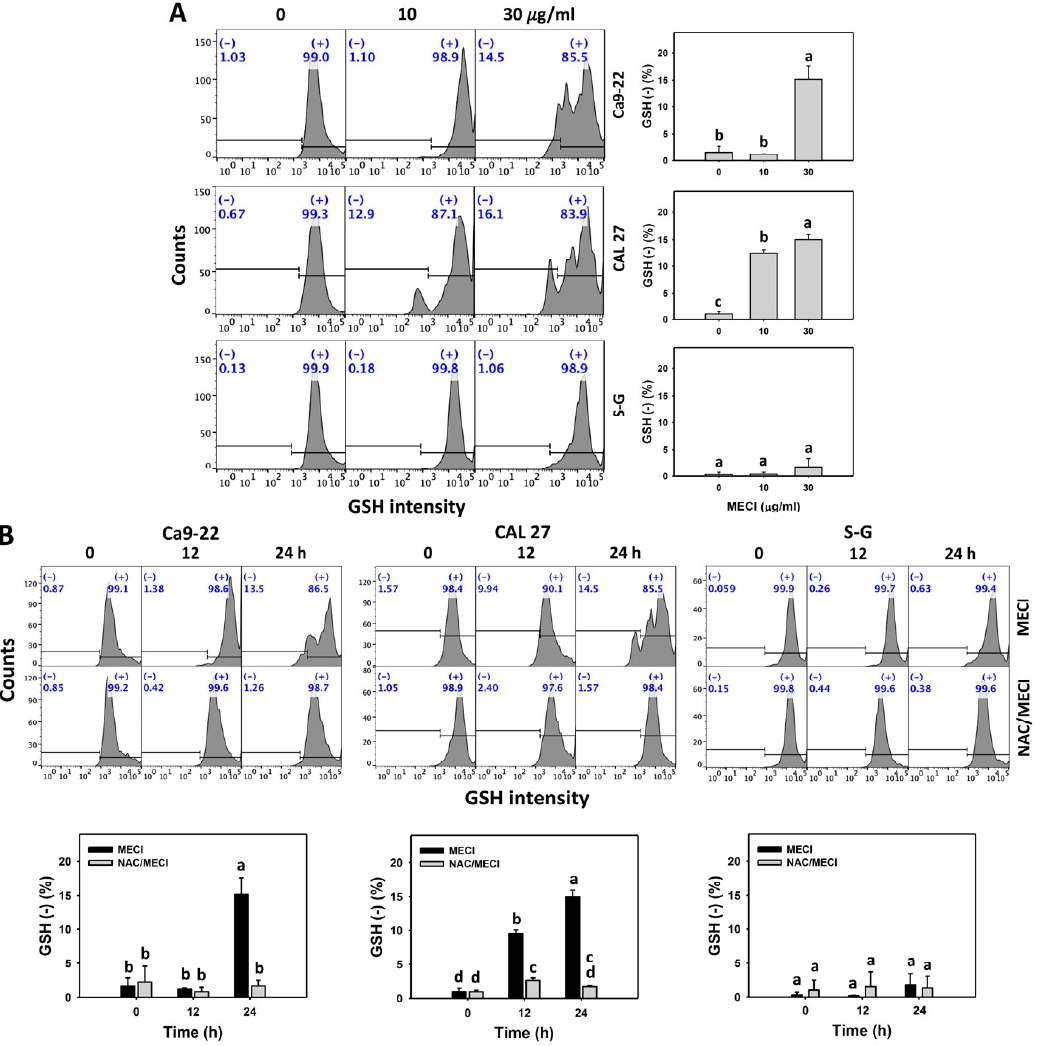
Figure 8. GSH assay. ( A ) GSH change. Except for S-G cells, other cells were oral cancer cells. After 24 h MECI incubation (0 (0.1% DMSO in the medium), 10, and 30 μ g/mL), cells were applied to a GSH assay. ( − ) spots were specified for GSH ( − ). ( B ) Impact of NAC on MECI-induced GSH change to oral cancer cells. After pretreating with NAC, cells were post-treated with MECI (30 µ g/mL) for 0, 12, and 24 h. Data, mean ± SD ( n = 3). For the same cell line, columns showing non-overlapping letters differ significantly ( p < 0.05).